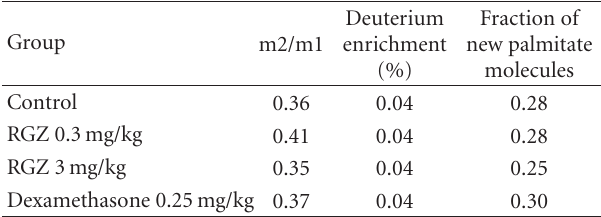
Table 2: E ff ect of RGZ on fatty acid synthesis. At 19 weeks, the fraction of de novo lipogenesis and incorporation into the tissues were analyzed by deuterium labeling and mass